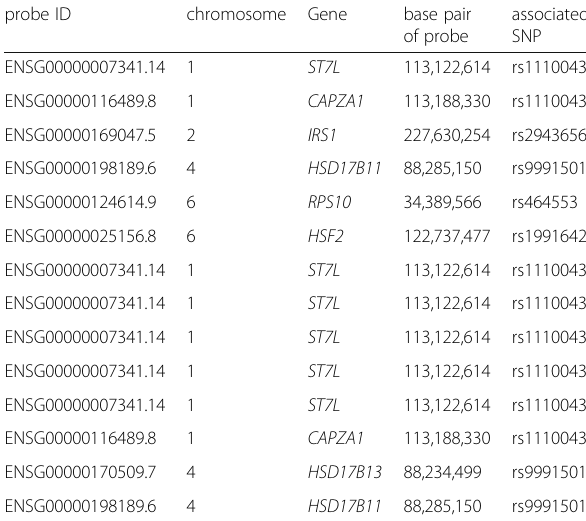
Table 5 Metal SMR of GTEx eQTLs and appendicular lean mass GWAS